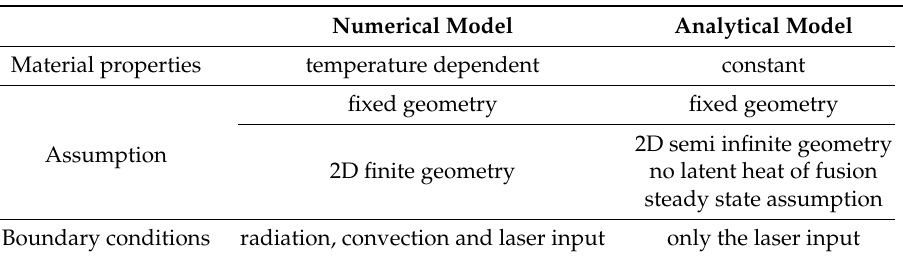
Table 1. Model comparison.